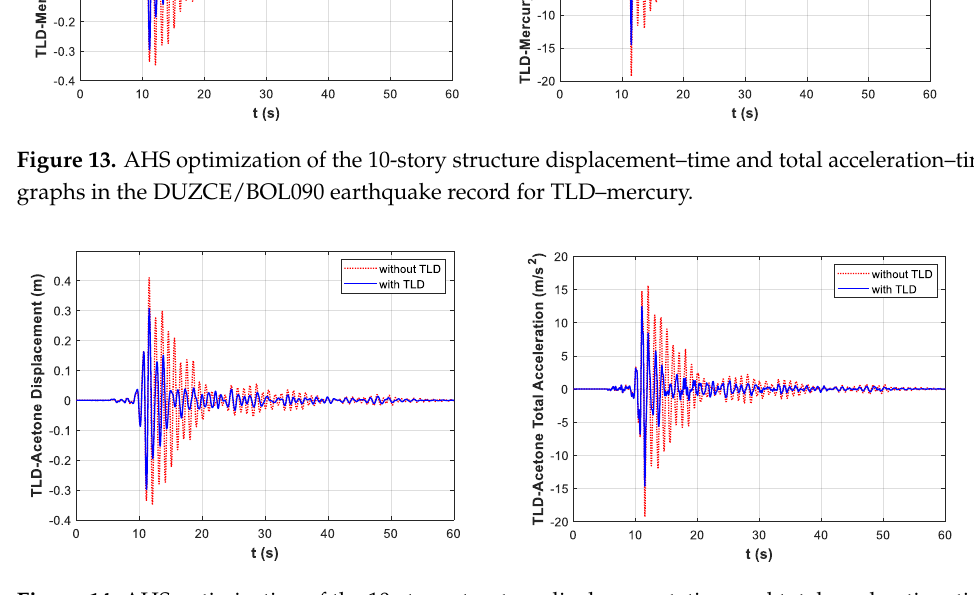
Figure 14. AHS optimization of the 10-story structure displacement – time and total acceleration – time graphs in the DUZCE/BOL090 earthquake record for TLD – acetone.